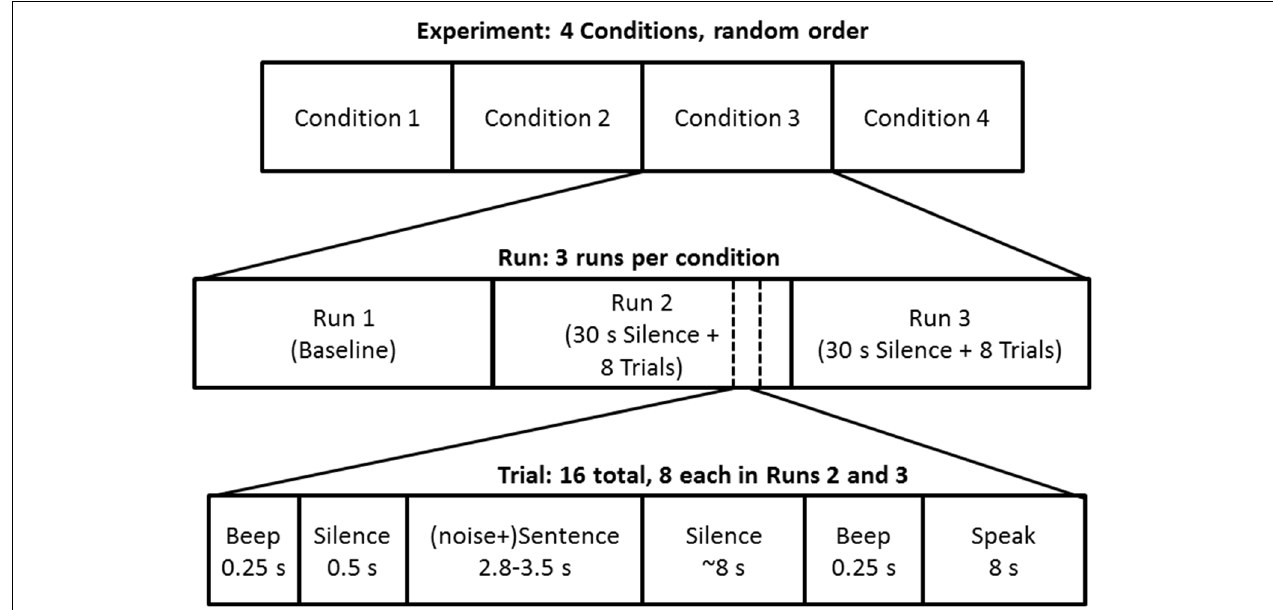
FIGURE 1 | Schematic diagram of experiment structure, highlighting the sequence of events in experimental trials within runs, and runs within